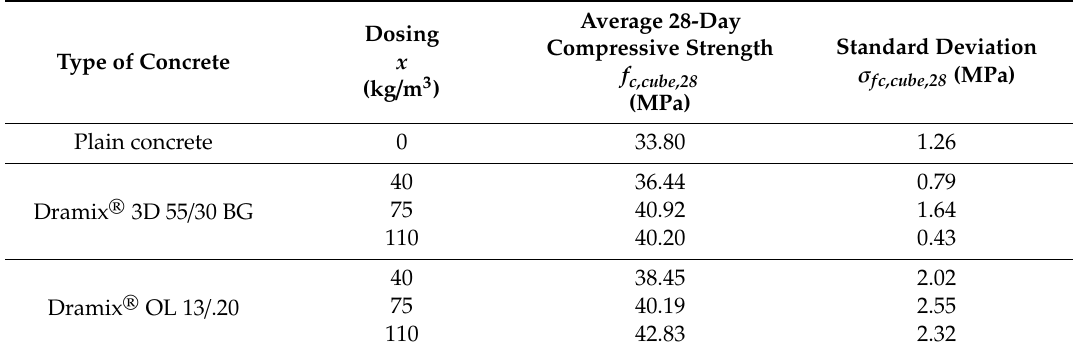
Table 2. Material properties of plain concrete and fiber-reinforced concrete: compressive strength.